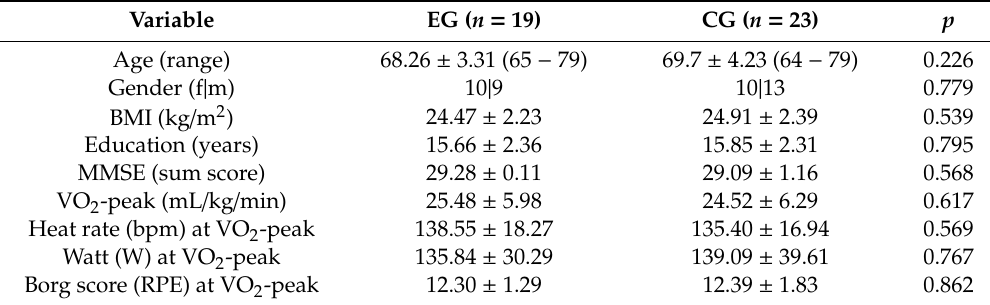
Table 1. Participant characteristics of the experimental (EG) and control group